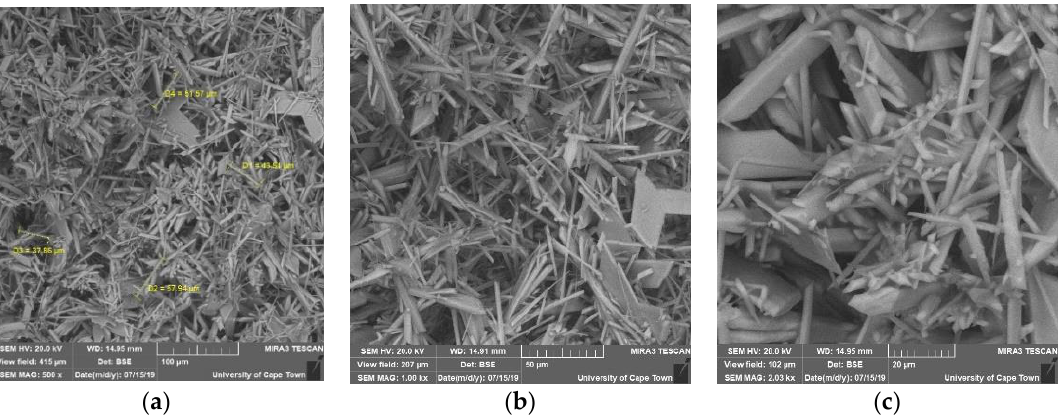
Figure 6. Micrographs of a scaled tube after running the experiment for 48 h. Scale bar = 100 µm ( a ), 50 µm ( b ) and 20 µm ( c ) respectively.